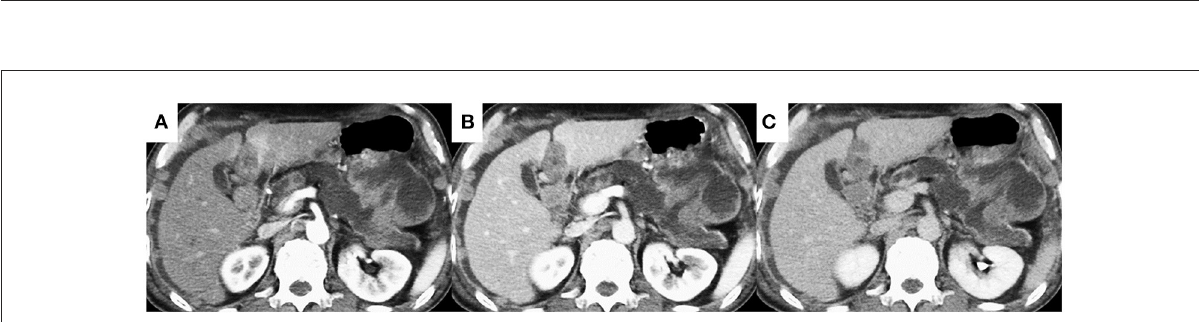
FIGURE2 Dynamic contrast-enhanced computed tomography shows that the pancreatic tail mass has solid and cystic components. The solid components of the lesion showed hypo-enhancement, whereas the cystic components of the lesion showed non-enhancement during all phases (A) arterial phase, (B) portal phase, (C) equilibrium